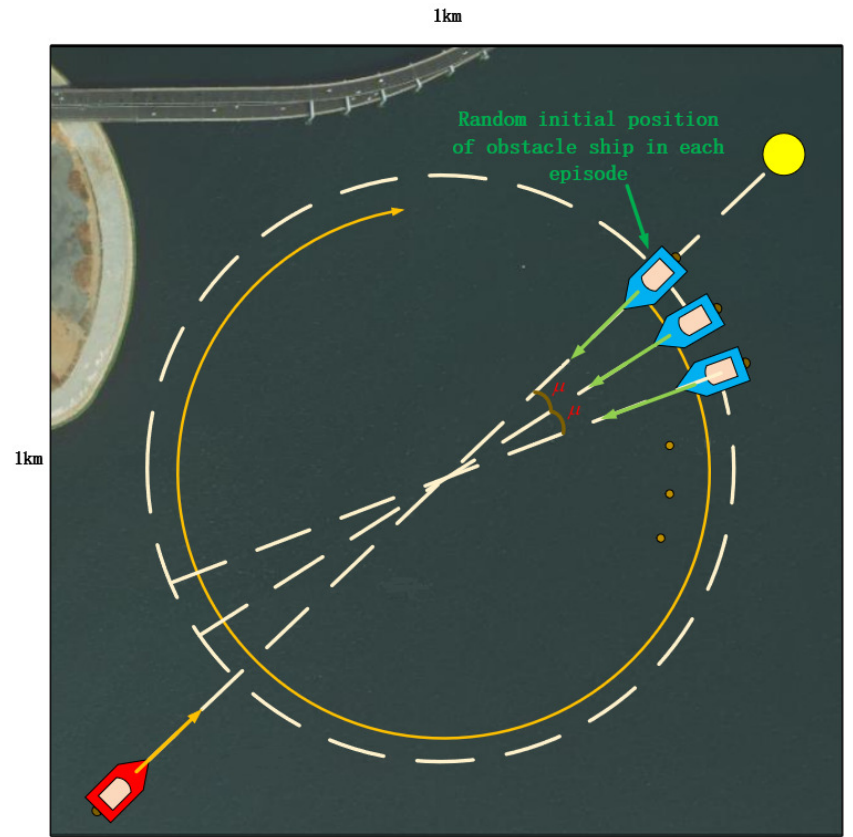
Figure 12. Training environment of the USV collision avoidance algorithm.